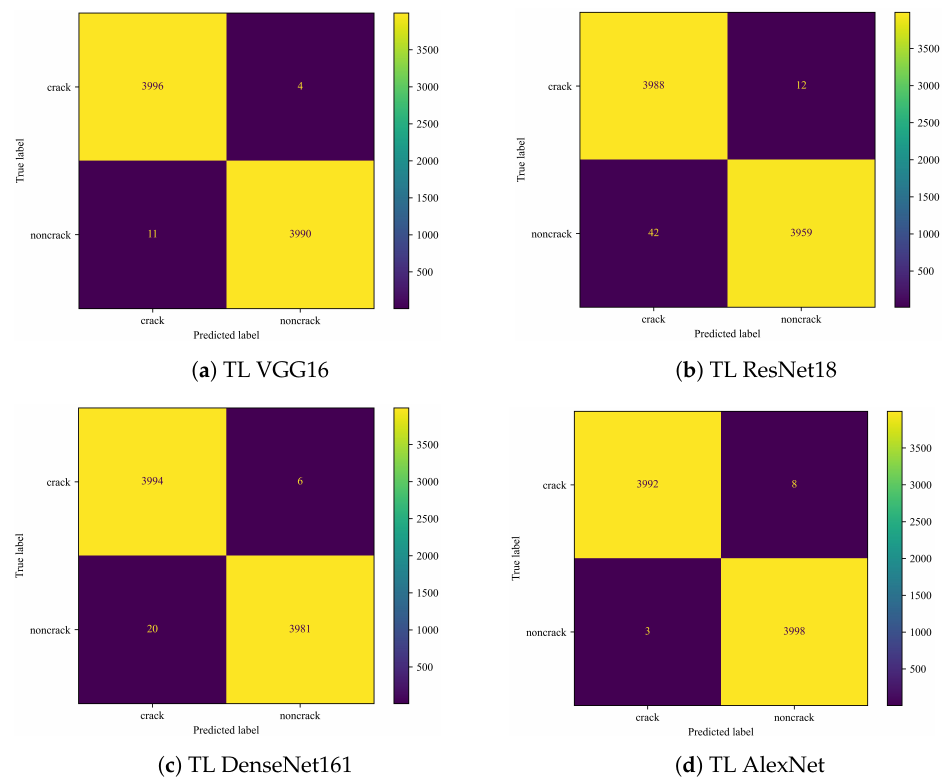
Figure 12. Confusion matrix of TL VGG16, TL ResNet18, TL DenseNet161, and TL AlexNet. The TL ResNet18, on the other hand, predicts 3988 (TP) cracks and 3959 (TN) non- cracks images correctly, as well as 12 (FN) cracks images predicted as non-crack and 42 (FP) non-cracks images predicted as cracks Figure 12b. In this case, the number of FP is the highest among other